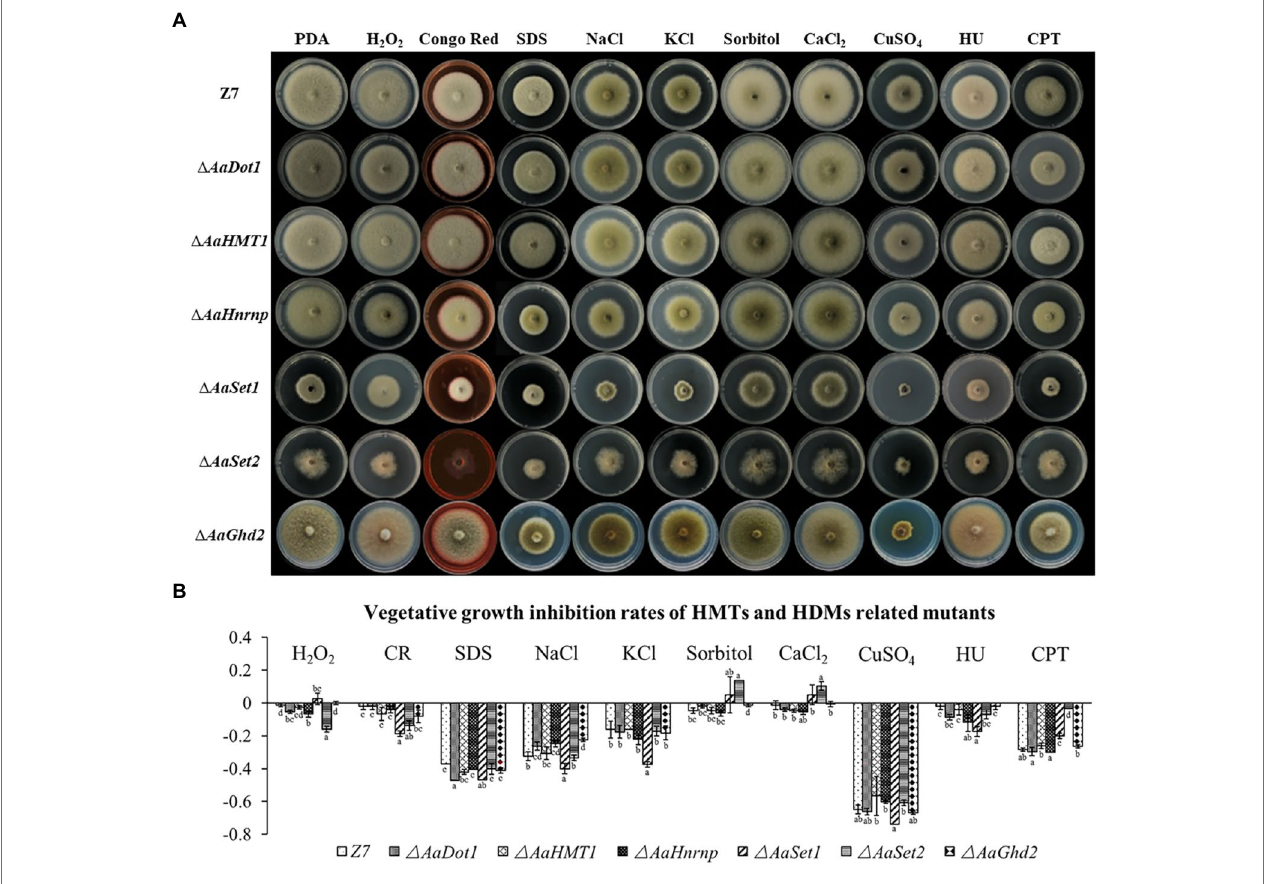
FIGURE 3 | Chemical sensitivity assays. (A) HMTs- and HDMs-related genes knock out mutants and wild-type Z7 was grown on PDA amended with or without the indicated chemicals. (B) Quantitative analysis (the growth inhibition rate of strains on PDA amended with tested chemicals compared to corresponding strains on PDA) of mutants and wild type. Computational formula: [dia. (Z7 or mutant under stress) − dia. (Z7 or mutant in PDA) ]/dia. (Z7 or mutant in PDA)